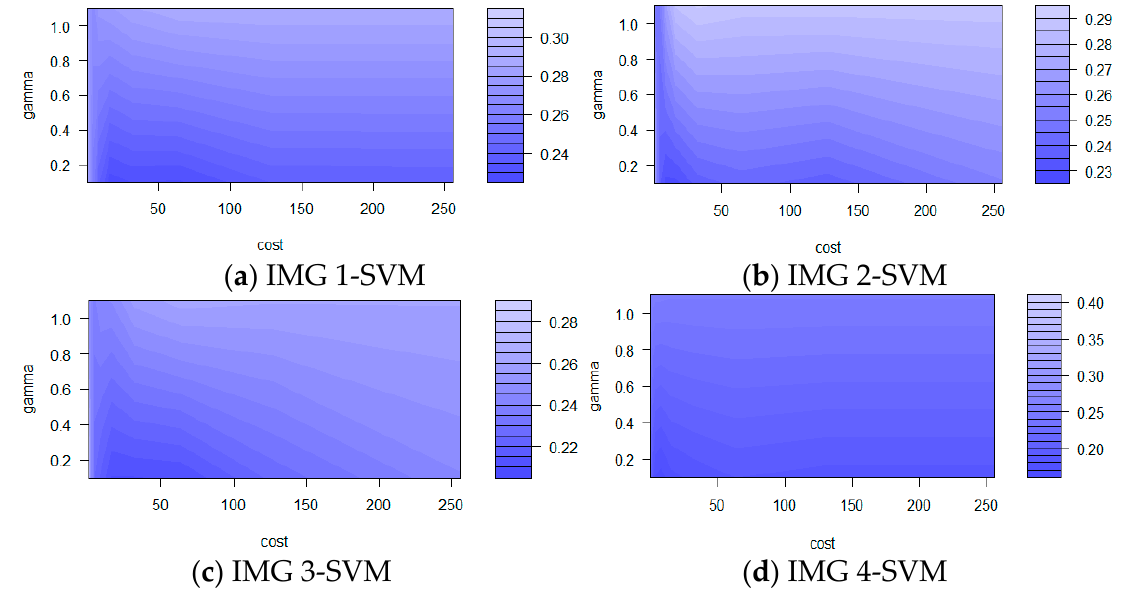
Figure 3. Parameter tuning of support vector machine: ( a ) IMG1-SVM; ( b ) IMG 2-SVM; ( c ) IMG 3-SVM; ( d ) IMG 4-SVM.